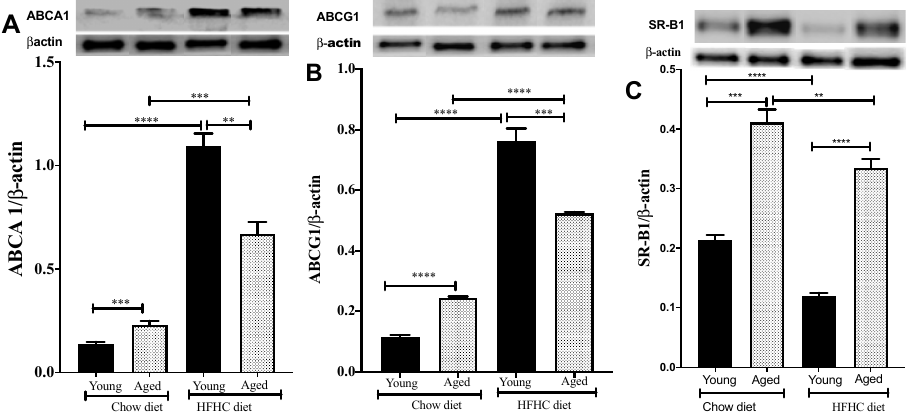
Figure 4. An HFHC diet affects ABCA1/ABCG1 and SR-BI protein expression by hepatic cells. Young and aged mice were fed chow or an HFHC diet for 12 weeks. They were then euthanized and ( A ) ABCA1, ( B ) ABCG1, and ( C ) SR-B1 protein expression in their livers was measured by Western blotting. Data are expressed as means ± SEM ** p < 0.0031, *** p < 0.0006, **** p < 0.0001 versus chow.